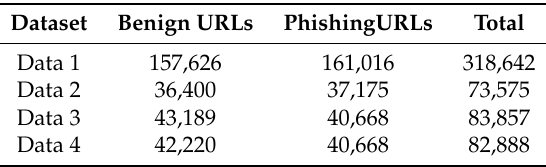
Table 3. Dataset distributions.